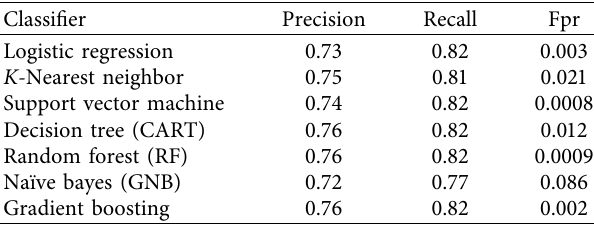
Figure 6: Stacked generalization architecture with 7 weak learners and one fnal metal-model. Table 3: Overall cross-validation scores from the seven classifers.